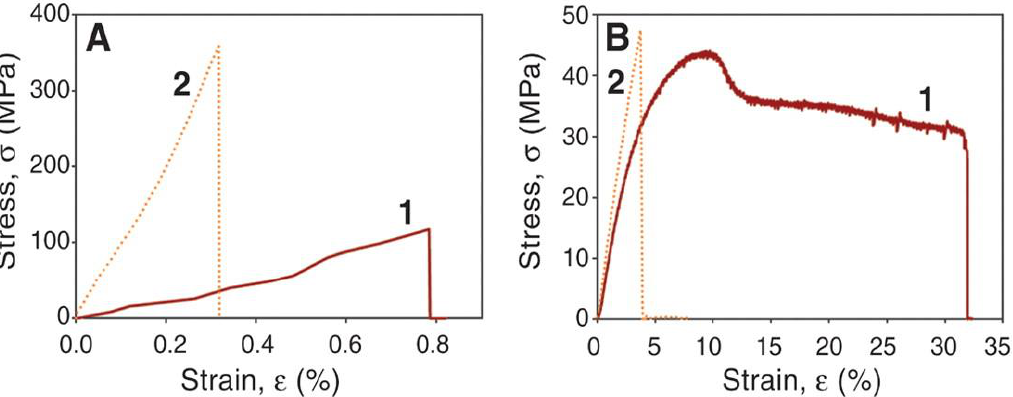
Figure 10. Mechanical properties of PVA/montmorillonite nano-assemblies ( A ) and neat PVA ( B ) without (1) and with (2) glutaraldehyde. Reproduced from [73], with permission from Science Inter- national.